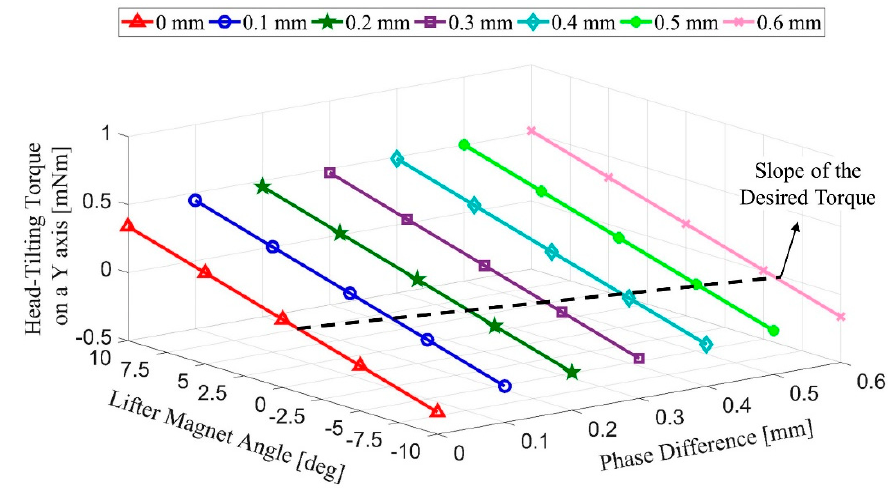
Figure 2. The angle calculation to be applied to the lifter-magnet is presented to eliminate undesired torque.